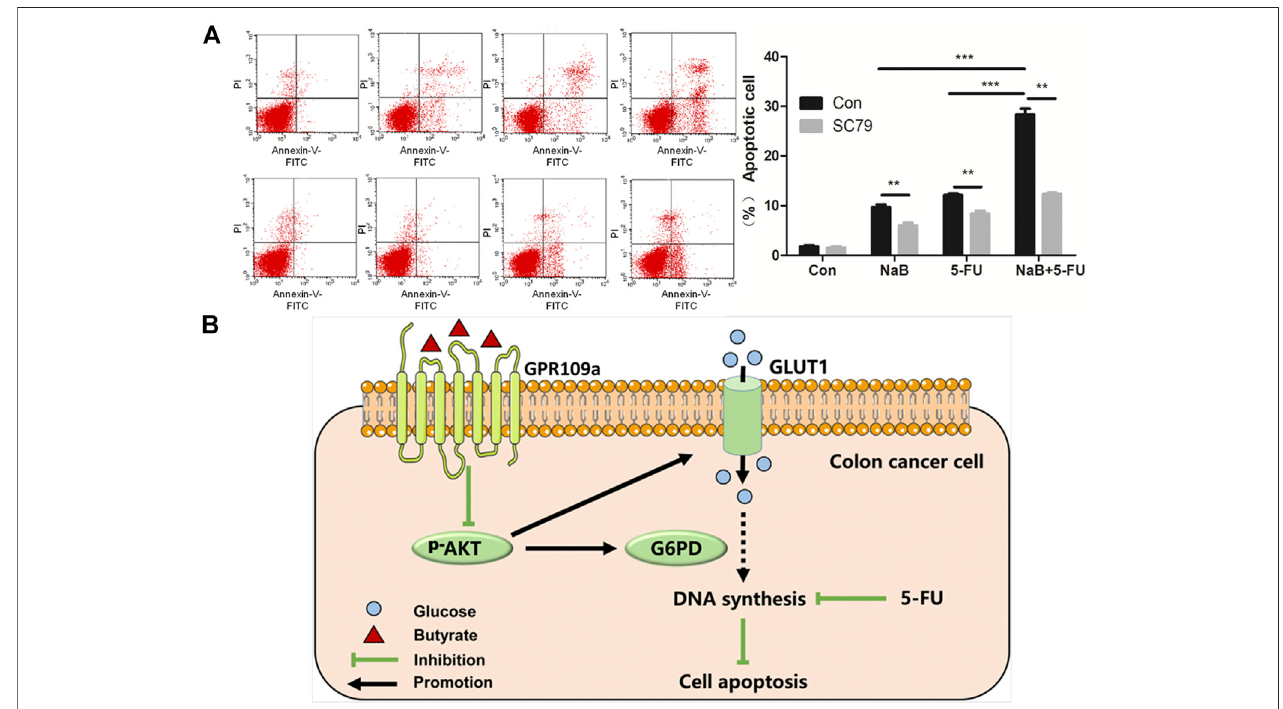
FIGURE 5 | Butyrate enhanced the chemotherapeutical ef fi cacy of 5-FU on HCT116 cells. (A) The apoptosis behaviors of HCT116 cells under various treating condition were measured using fl ow cytometry. In the fi rst row (marked as “ Con ” on the left side), the apoptosis activities of HCT116 cells under four growth conditions were shown, which were treated with PBS vehicle (labeled as “ Con ” on the top side), 2 mM butyrate (labeled as “ NaB ” ), 1.92 μ M 5-FU (labeled as “ 5-FU ” ), or the combination of 2 mM butyrate and 1.92 μ M 5-FU (labeled as “ NaB+5FU ” ). In the second row, the apoptosis activities of HCT116 cells under various growth conditions as well as extra addition of 10.96 μ M SC79 were displayed (marked as “ SC79 ” on the left side). (B) A schematic view illustrating the combined effects of butyrate and 5-FU on the DNA synthesis and apoptosis of colon cancer